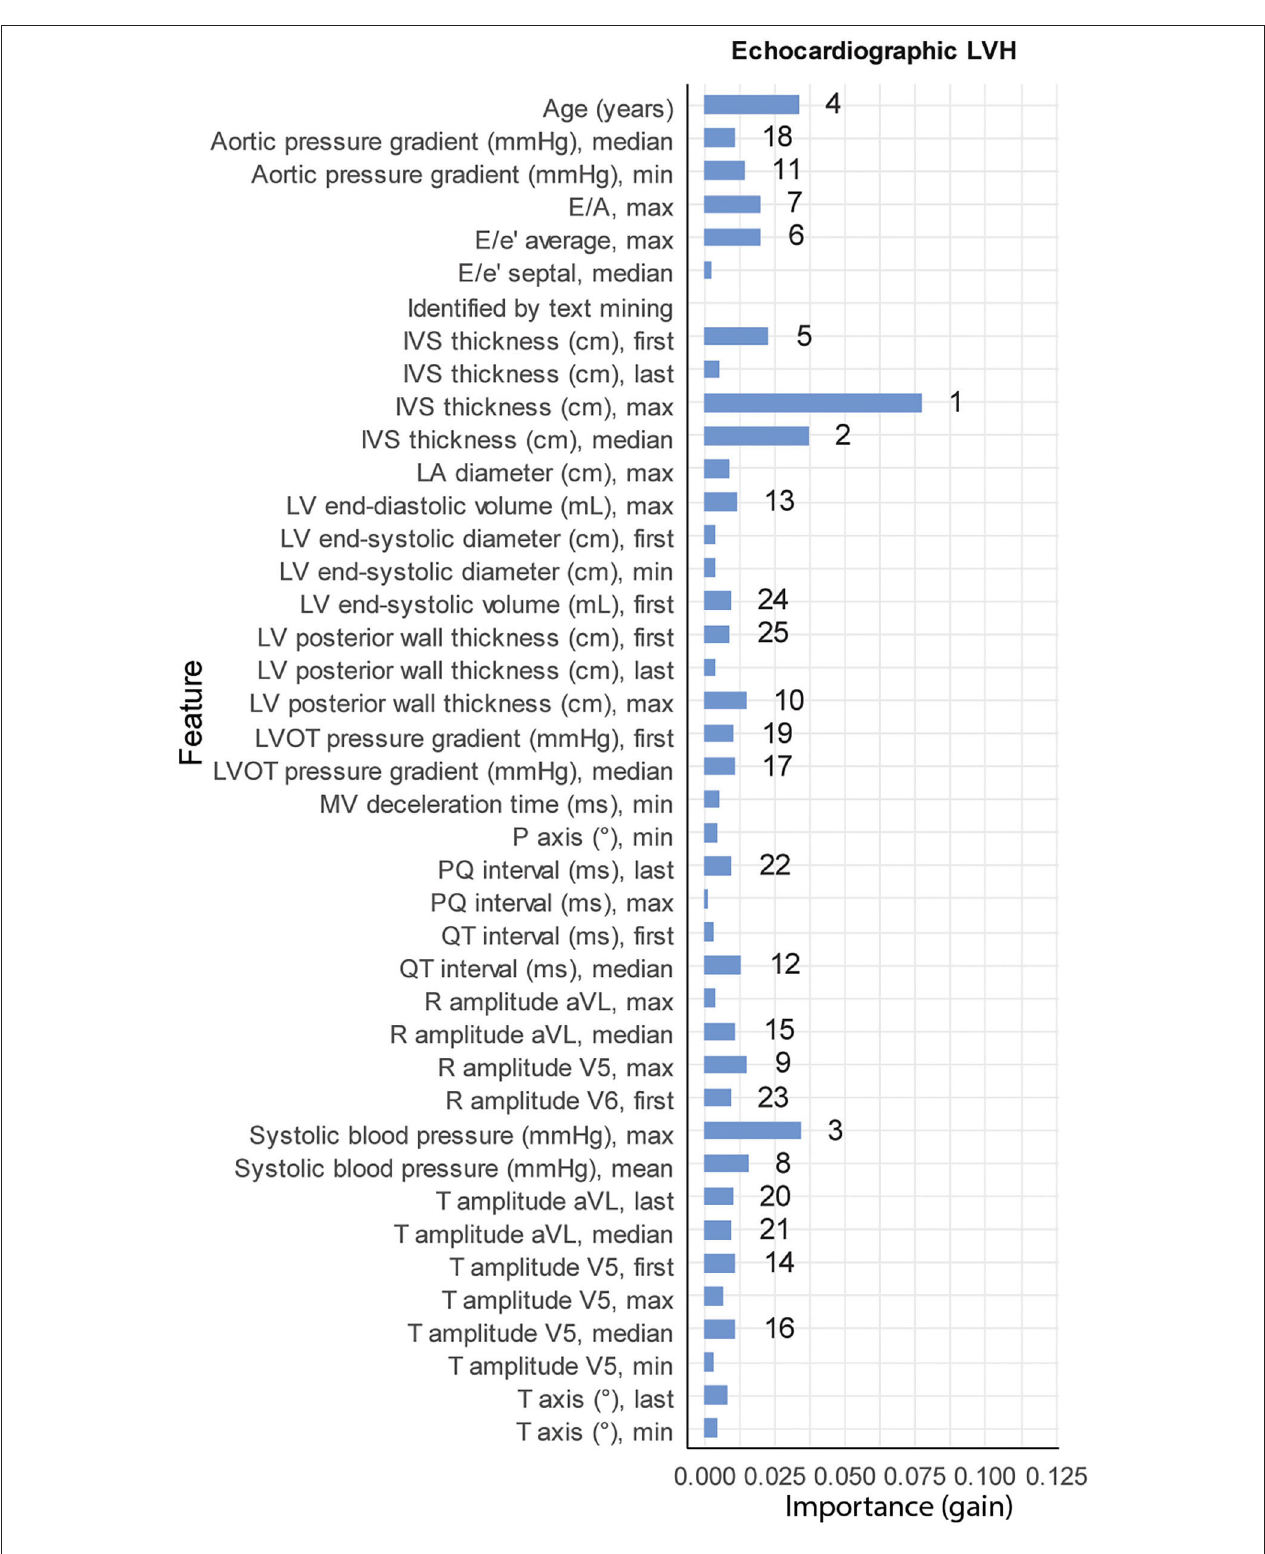
FIGURE 2 | Feature importance. Relative importance for the top 25 variables of each of the three XGBoost models (41 variables in total), measured by gain. Numbers denote the rank of the top 25 variables for each model (1 being the most important). LVH, left ventricular hypertrophy.